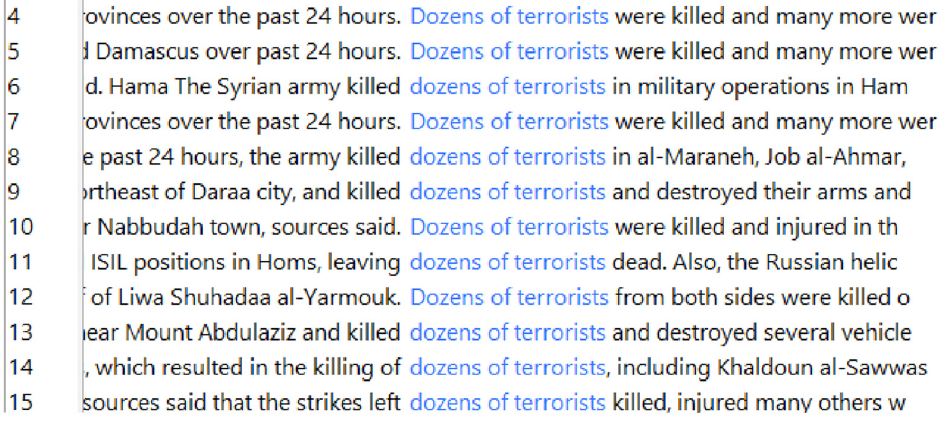
Figure 3: Concordance lines of